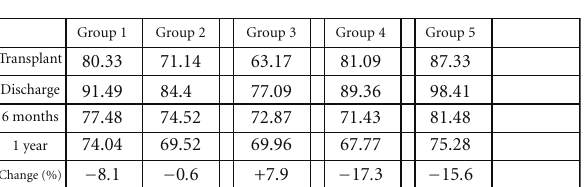
Figure 3: GFR (mL/min) outcome (mean). It depicts the glomeru- lar filtration rate (GFR) (mL/min) for the five categories of patients at the times of hospital discharge, 6 months, and 1 year.